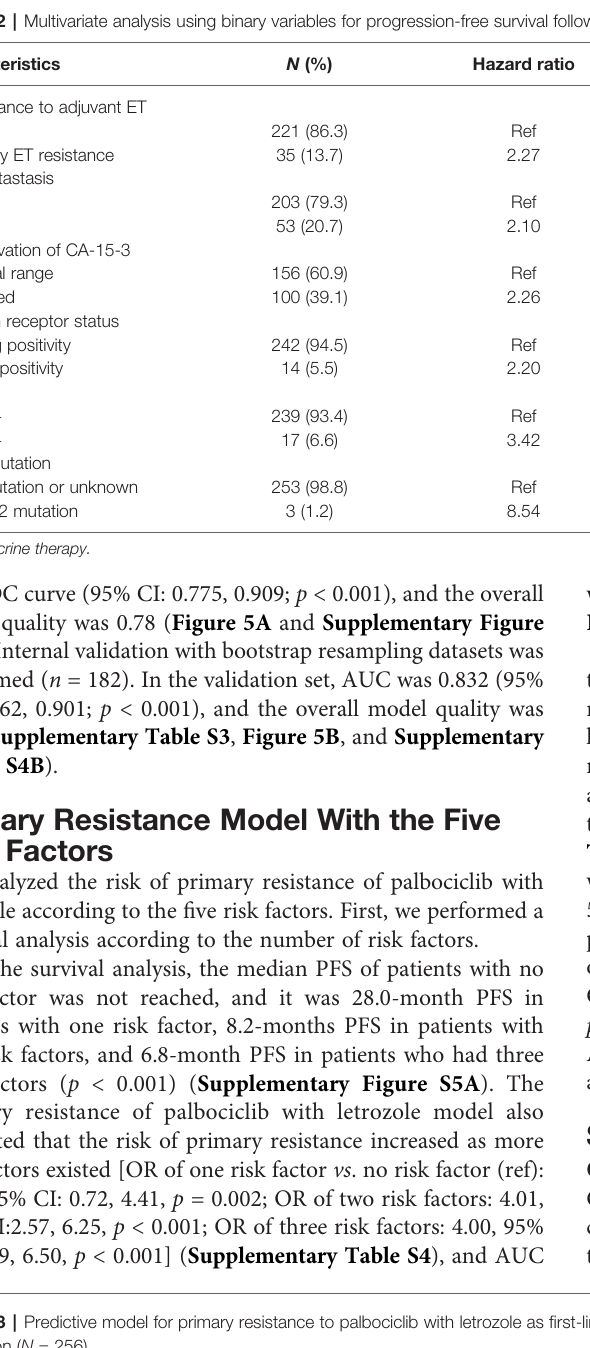
TABLE 3 | Predictive model for primary resistance to palbociclib with letrozole as fi rst-line treatment for HR+, HER2-advanced breast cancer using fi rth logistic regression ( N = 256). Characteristics Disease